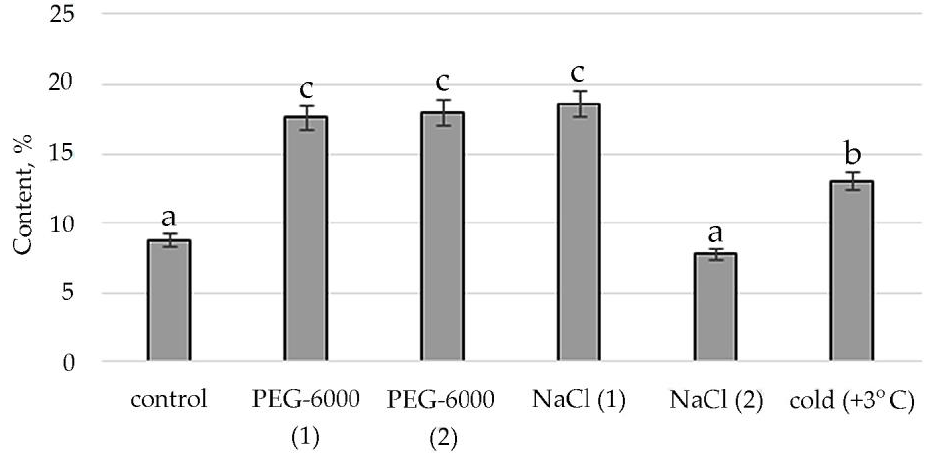
Figure 3. Change in content of hexadecanoic acid, ethyl ester in S. hybridum under stress conditions. Values presented are means ( ± SD). Different letters above the bars represent significant differences at p ≤ 0.05, n = 3 plants in each of 3 replicates for all treatments.